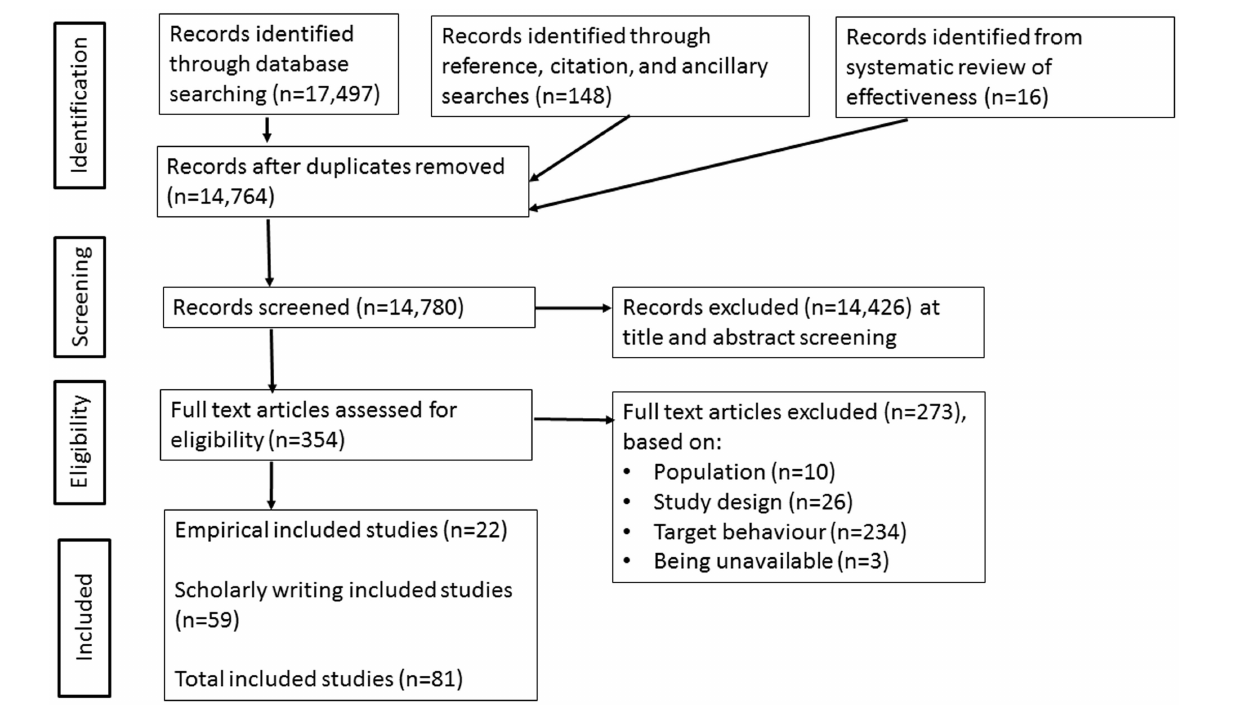
FIGURE 1 | PRISMA Flow